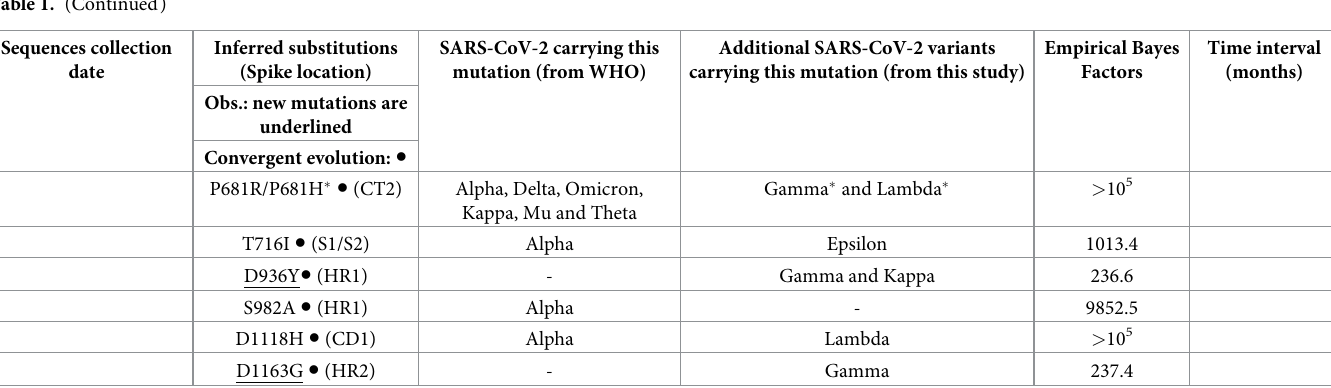
SARS-CoV-2 carrying this mutation (from WHO)